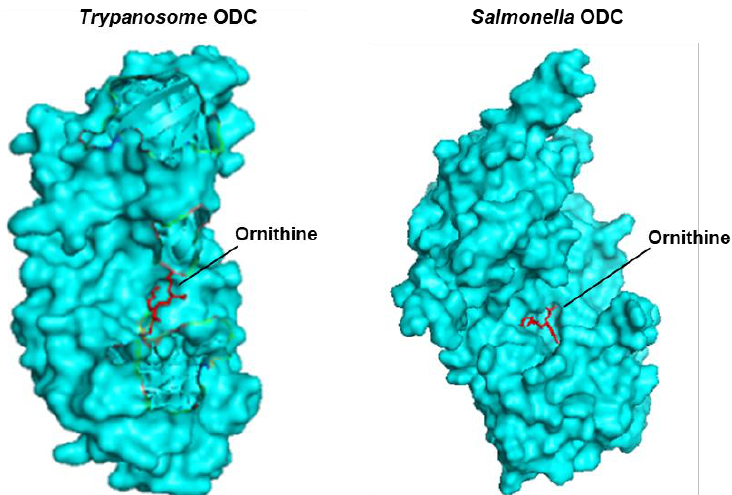
Figure 4. Structural comparison between ornithine docked into S. typhimurium ornithine decarboxylase (ODC) and the crystal structure of ornithine- T. brucei ODC complex, using CB-Dock2 (Supplementary material). The surface topology view of each structure, presented in PyMol (cyan color), shows the ornithine molecule (in red) in a crevice at approximately similar locations in the overall structure.